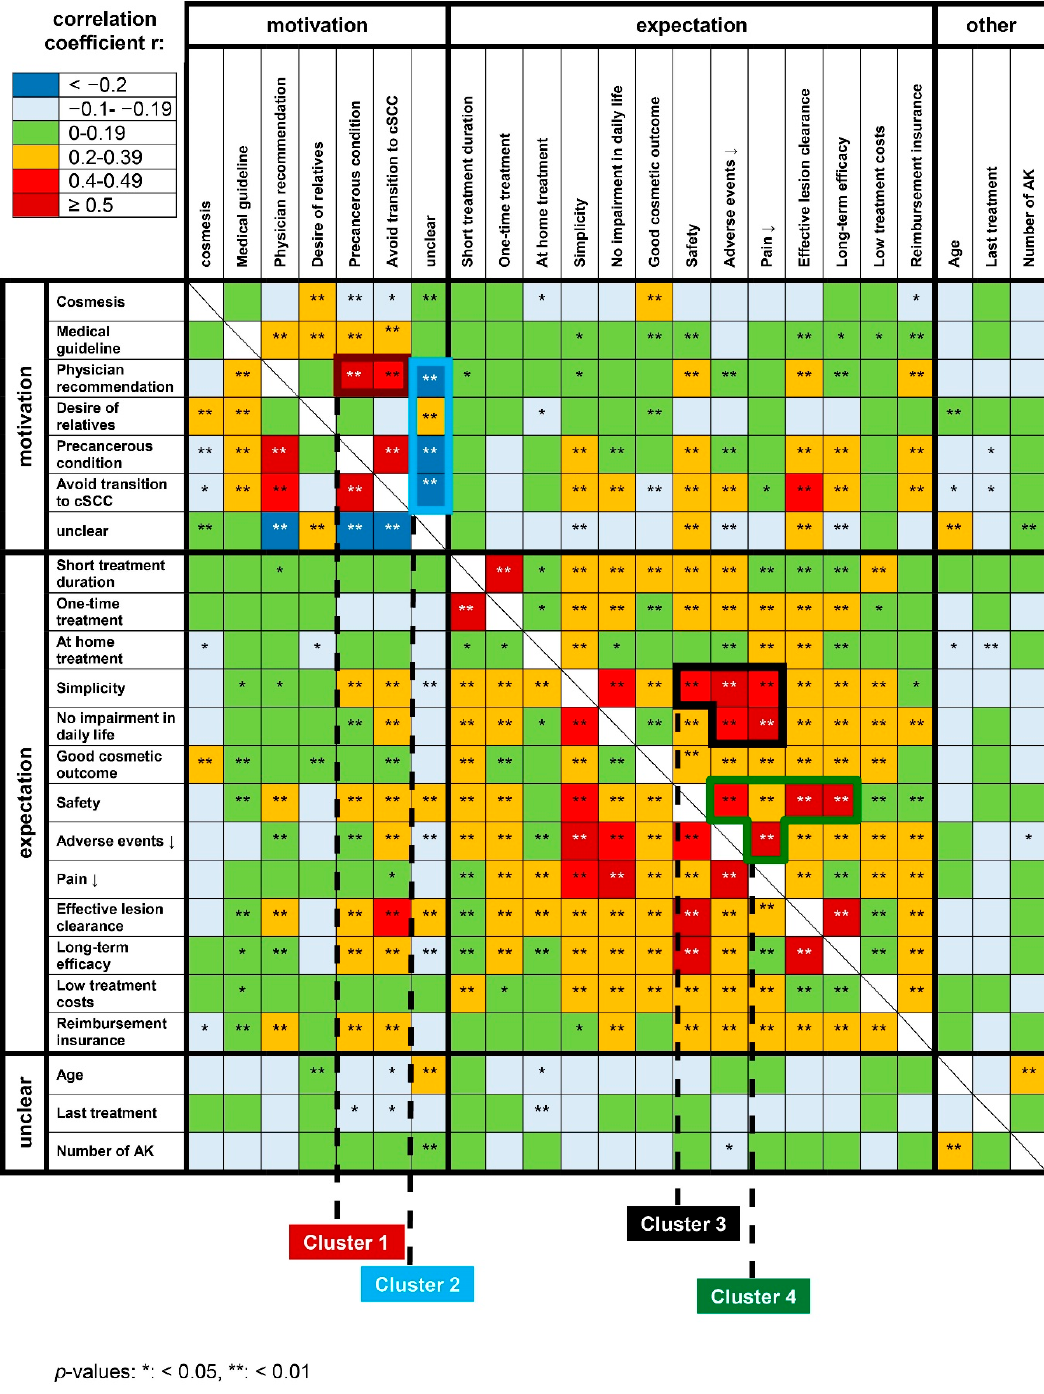
Figure 3. Heat ‐ map showing the correlations of patients’ motives and expectations towards AK Figure 3. Heat-map showing the correlations of patients’ motives and expectations towards AK management. The correlation coefficients were used to indicate the strength of the correlation. Four management. The correlation coe ffi cients were used to indicate the strength of the correlation. Four patient clusters were identified (black frames). patient clusters were identified (black